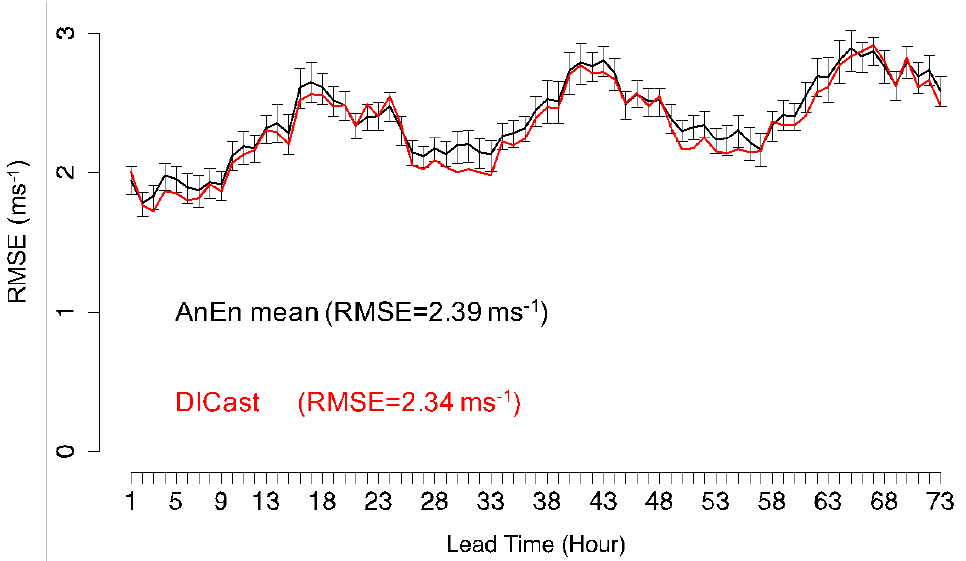
Figure 6. Root mean square error (RMSE) as a function of forecast lead time for DICast ( red ) and AnEn means ( black ) computed over all stations. Bootstrap 5%–95% confidence intervals are plotted for AnEn only. RMSE values listed are computed by including all lead times.